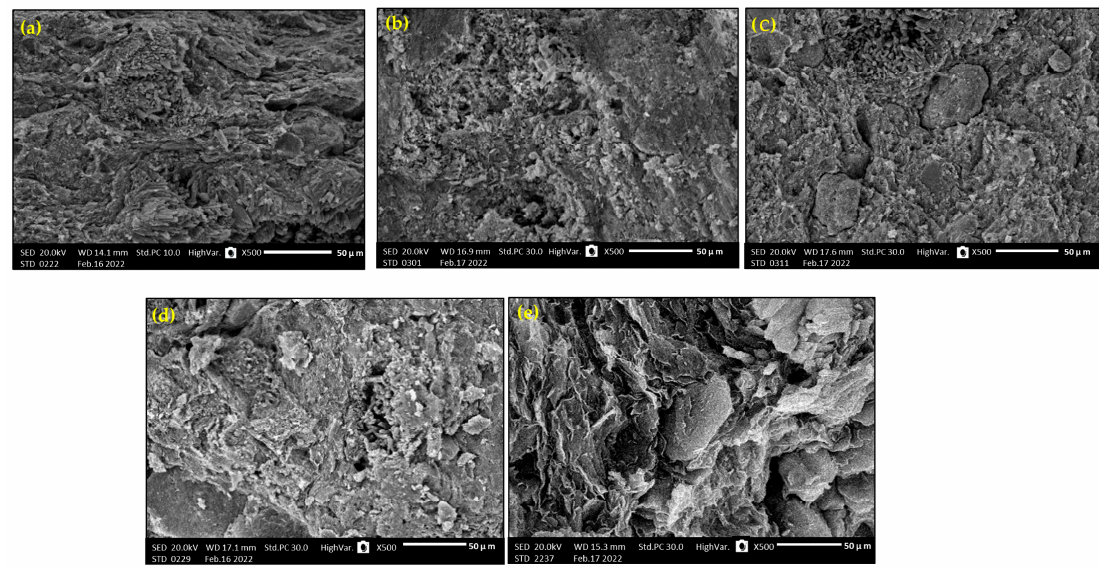
Figure 2. SEM images of ( a ) BG-0, ( b ) BG-1Micro, ( c ) BG-5Micro, ( d ) BG-1Nano, ( e ) BG-5 Nano.